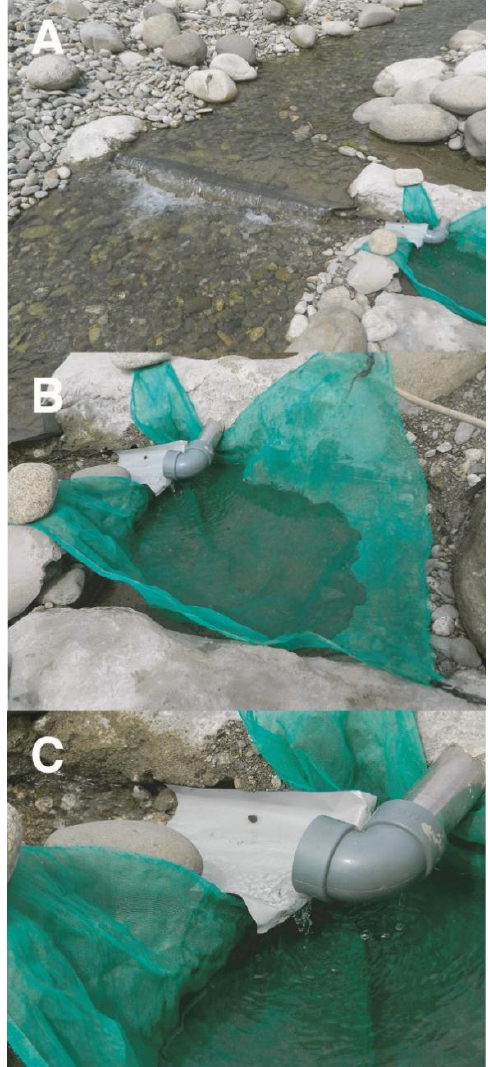
Figure 2. Trap net specifically designed to collect glass eels. ( A ) general overview of the trap; ( B ) collecting section; ( C ) close-up.